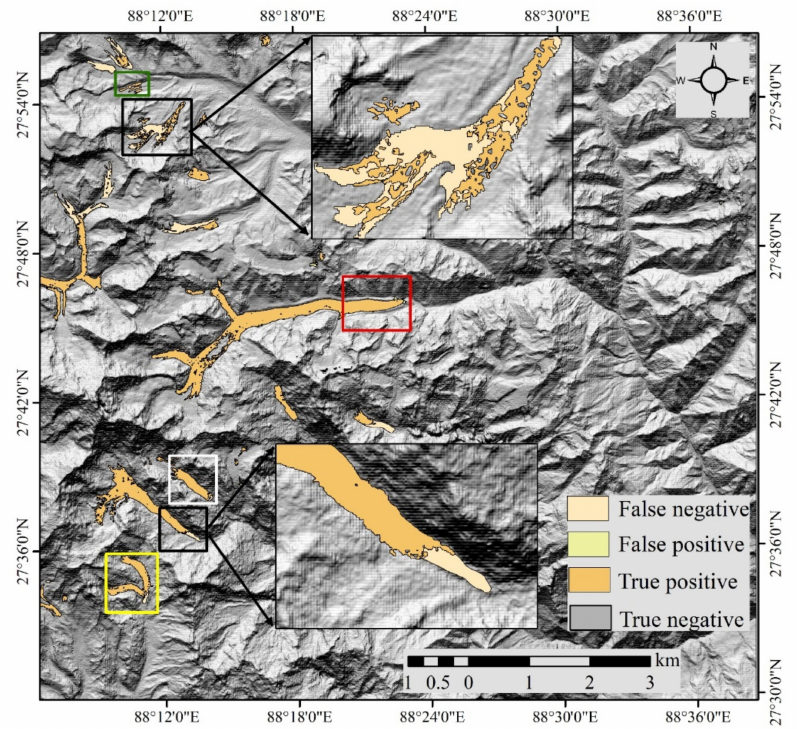
Figure 5. Supraglacial debris mapping in Sikkim, Eastern Himalaya using the proposed algorithm. False-positives and false-negatives were mapped manually using reference data. Red, white, green, and yellow boxes provide a contextual overview of the Figure